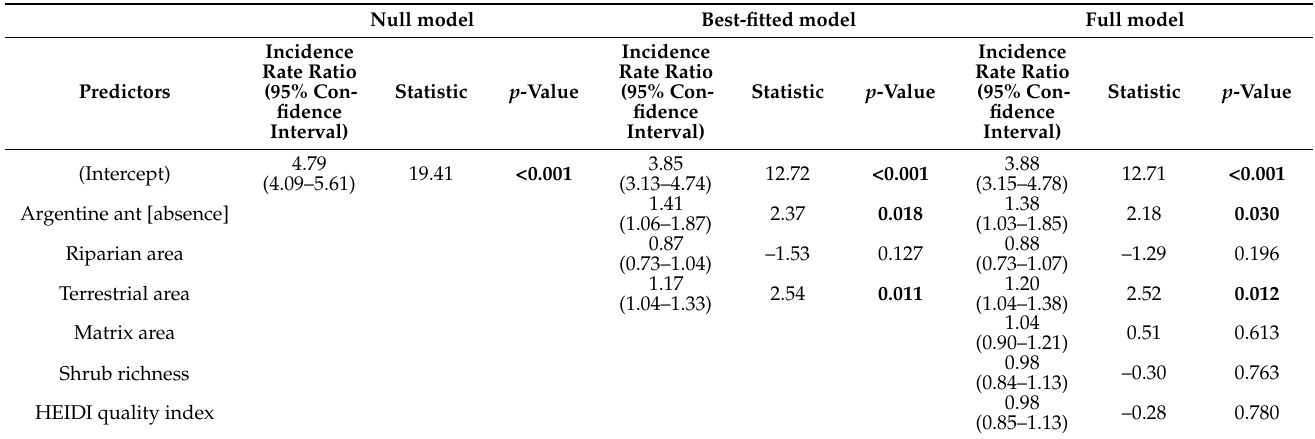
Table 3. Summary of the GLMMs model with the lowest AIC, compared with the Null and Full models, to test Hypothesis 4. Significant p -values ( p < 0.05) are displayed in